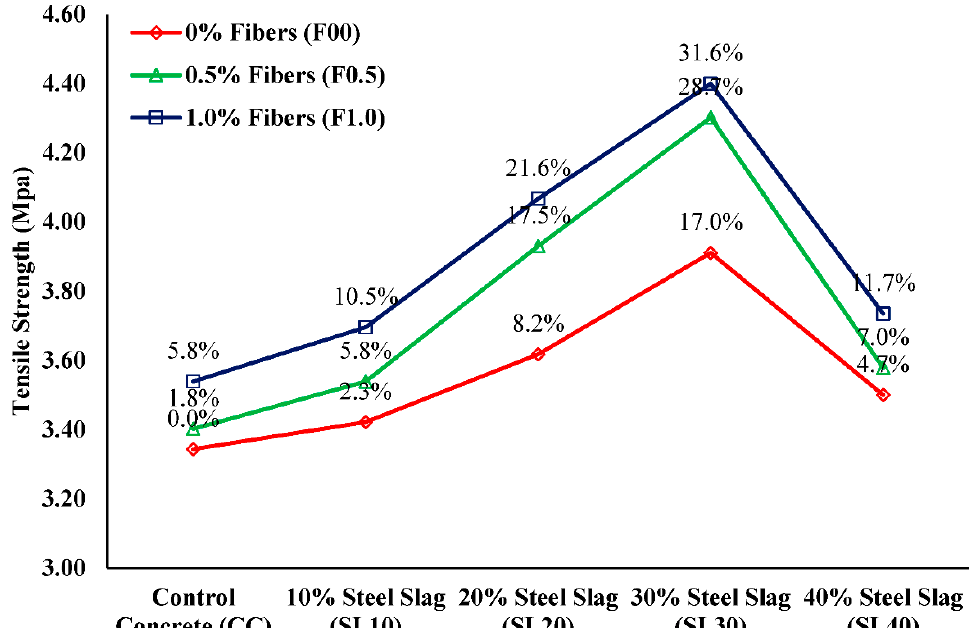
Figure 9. Compare and contrast of split tensile strength test results.